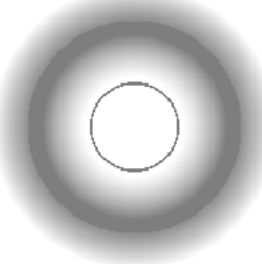
Figure 2. Illustration of uncertain quantitative distance and error following a normal distribution [5].